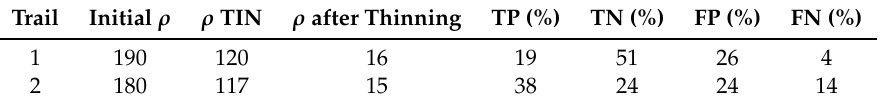
Table 3. The point cloud properties. Horizontal densities ρ are in m − 2 . The abbreviations TP, TN, FP and FN correspond to true and false positives and negatives given as